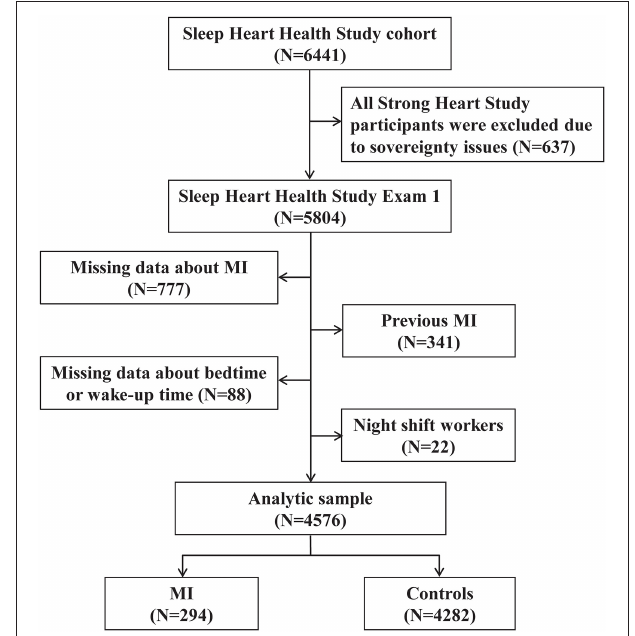
FIGURE 1 | Flow diagram of participant